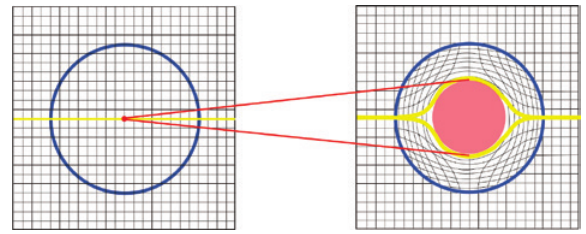
Figure 5: Illustration of the transformation of a disk into a ring (inspired by [63]).